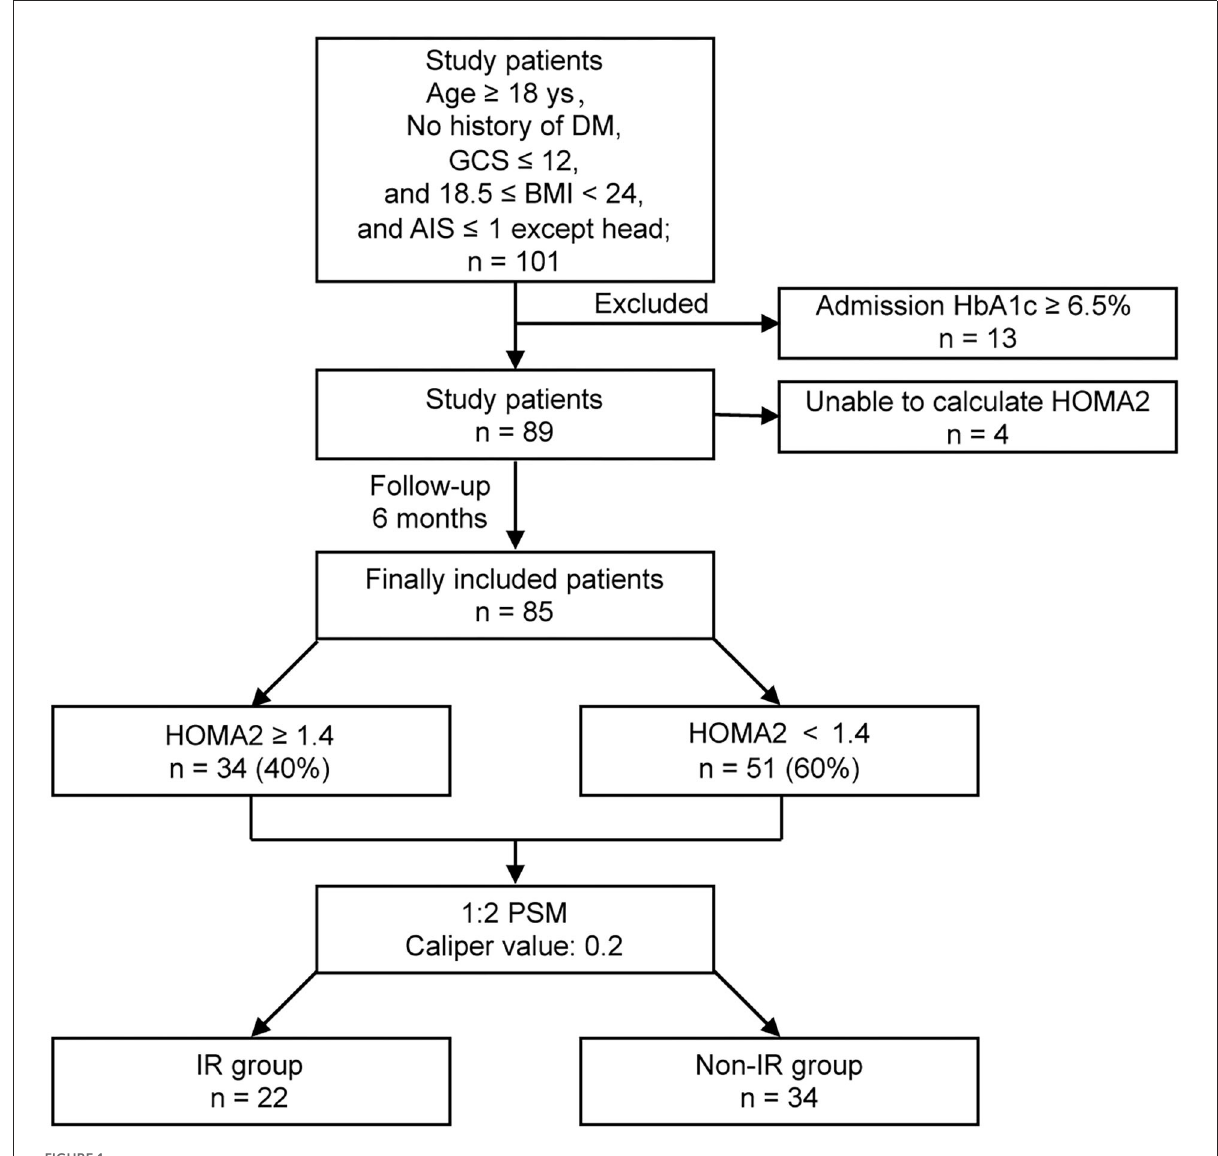
FIGURE1 Flow chart of the study groups.